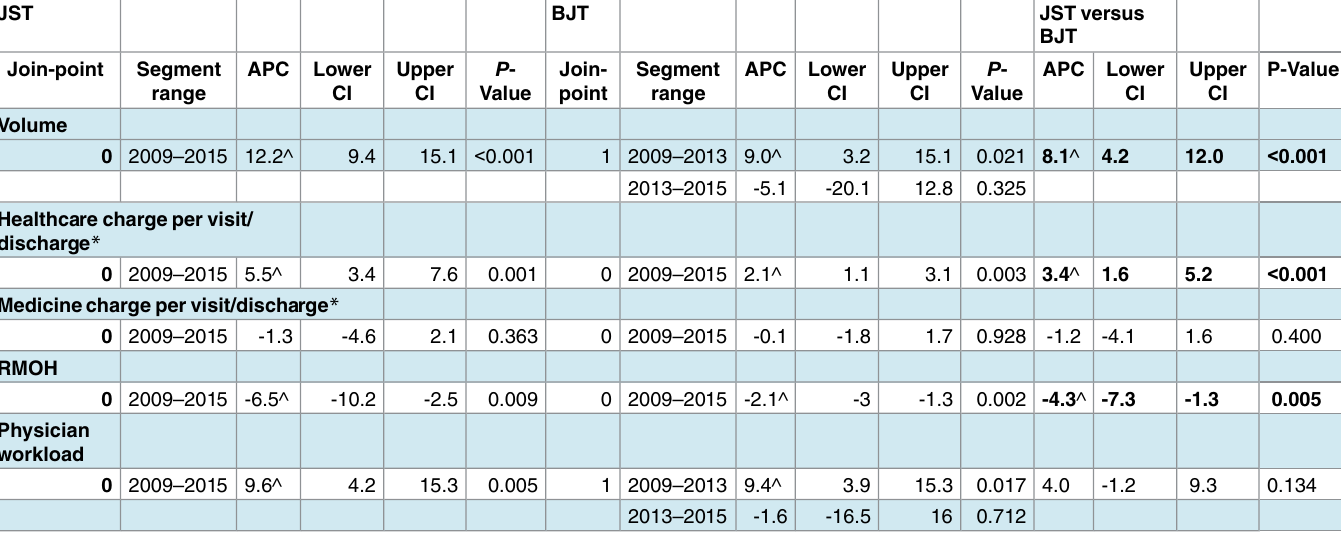
Table 3. The outpatient effectsassociated of the zero-markup drug policyimplemented in Dec 2012 at the JishuitanHospitalat Xinjiekou campus, Beijing,Chinain comparison withthe Beijingtertiaryhospitals. JST BJT JST versus